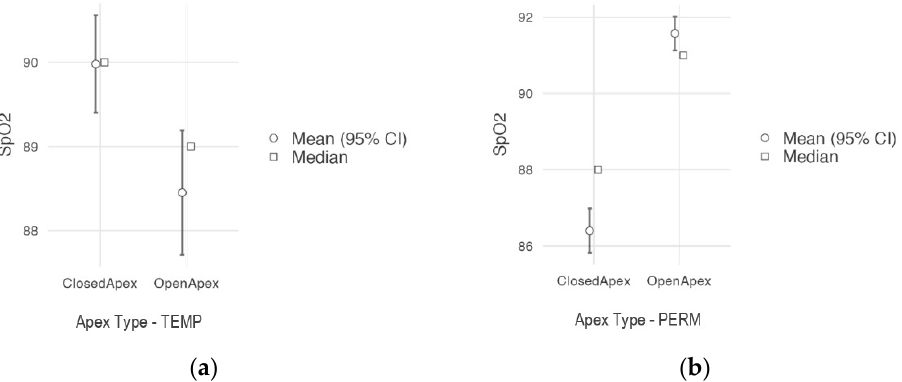
Figure 5. Graphic representations of SpO 2 measured in teeth with an open vs. a closed apex: ( a ) primary teeth; ( b ) permanent teeth.